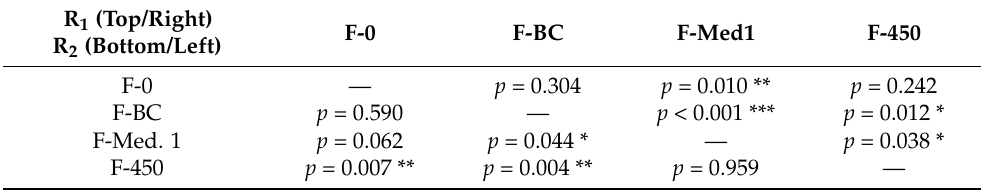
Table 5. Spearman’s rank correlations between the parameters of the Rayleigh and Moreland tests. It should particularly be noted that there is a strong correlation between R W and most of the Moreland test parameters for each of the filter types.